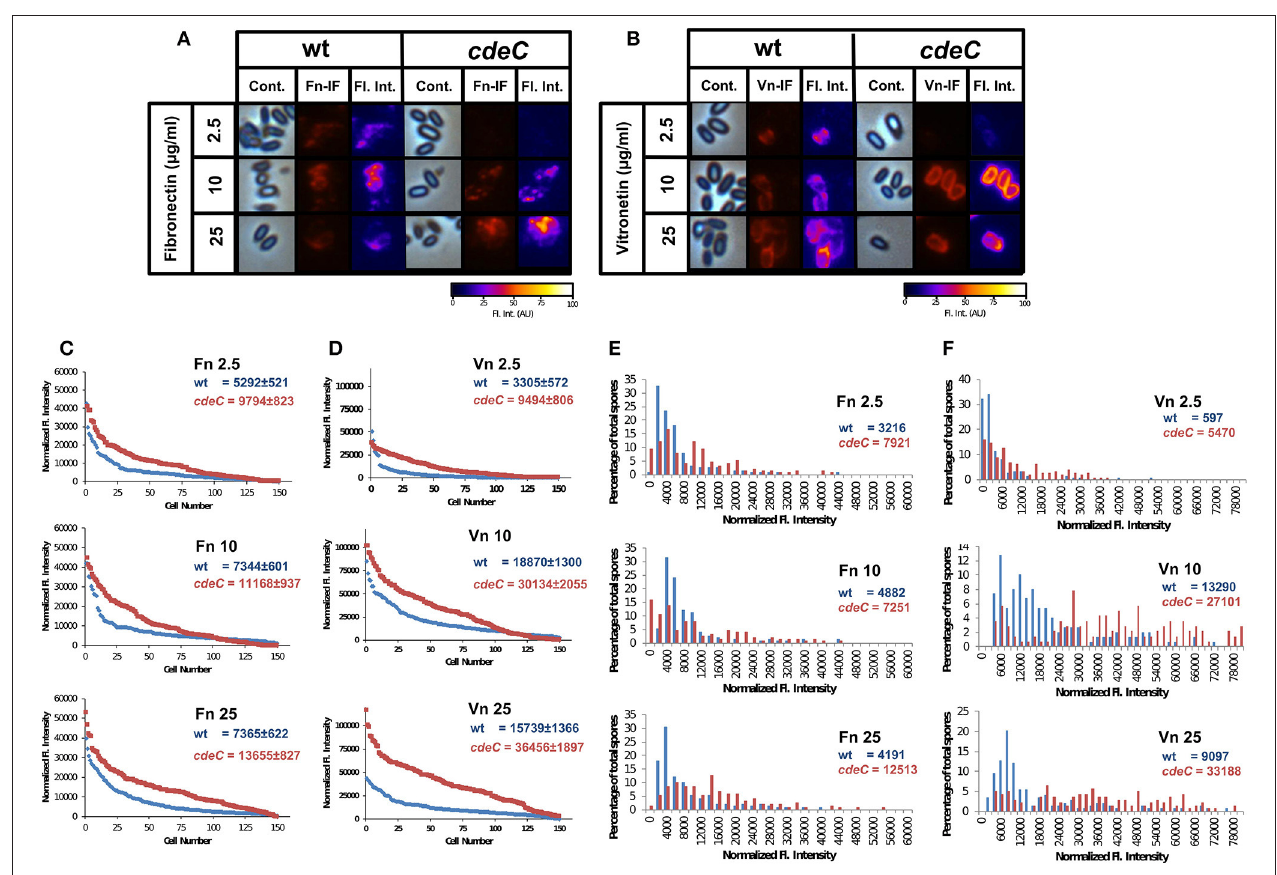
FIGURE 6 | Variability in the binding of fibronectin and vitronectin to C. difficile spores. (A,B) C. difficile spores of wild-type (wt) and cdeC strains were incubated with various concentrations of fibronectin (A) and vitronectin (B) for 1h at 37 ◦ C, centrifuge and stained by immunofluorescence for fibronectin and vitronectin as described in the Method section. Representative phase contrast (Cont.) and fibronectin- (Fn-IF) and vitronectin-specific (Vn-IF) immunofluorescence micrographs are shown for wild-type and cdeC spores. Fluorescence intensity (Fl. Int.) profiles of wild-type and cdeC mutant spores were provided by fluorescence microscopy images using the 3D Surface plotter function of ImageJ (http://imagej.nih.gov/ij/). (C,D) Quantitative analysis of the fluorescence (Fl.) intensity in spores of wild-type (blue line) and cdeC mutant (red line) incubated with different concentrations (i.e., 2.5, 10, and 25 µ g/ml) of fibronectin (Fn) (C) or vitronectin (Vn) (D) . The values shown in the graphs are the average ± standard error of the fluorescence intensity from 150 spores from wild-type (wt) and cdeC strain. (E,F) Distribution of the fluorescence intensity of wild-type (wt, blue bars) and cdeC spores ( cdeC , red bars) incubated with various concentrations (i.e., 2.5, 10, and 25 µ g/ml) of fibronectin (Fn) (E) or vitronectin (Vn) (F) . The median of the fluorescence intensity of wild-type and cdeC spores is shown in each panel. The data shown in (C–F) are from one experiment that is representative of three independent